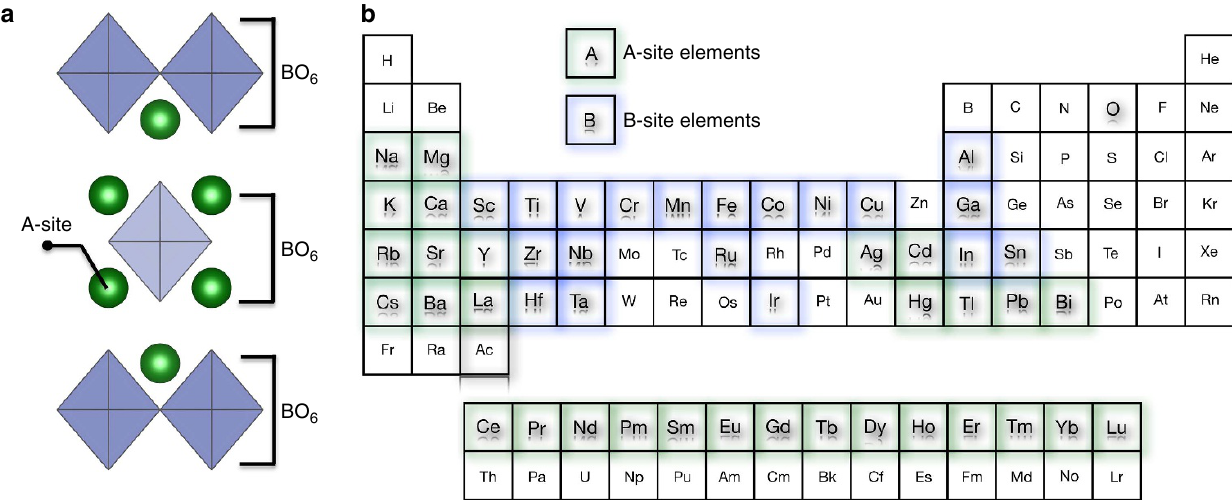
Figure 1 | Octahedral connectivity of n ¼ 1 RP oxides and the chemical search space. ( a ) The n ¼ 1 RP phase has a single layer of octahedra that are connected in two dimensions, shown within brackets, whereas there is no connectivity in the third dimension. ( b ) Periodic table showing the potential 30 A-site and 19 B-site elements that occupy the n ¼ 1 RP phase. In principle, there are more than 19 B-site elements when we also consider the multiple valence states of certain elements (for example, Mn, Fe, Co, Ni and so on). This defines the chemical space for our informatics